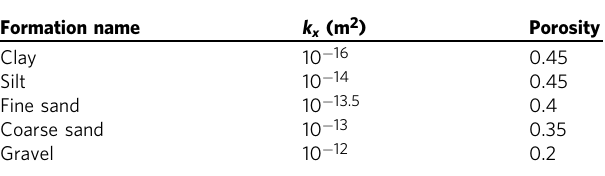
Table 3 Material properties assigned to different formations in hydrological